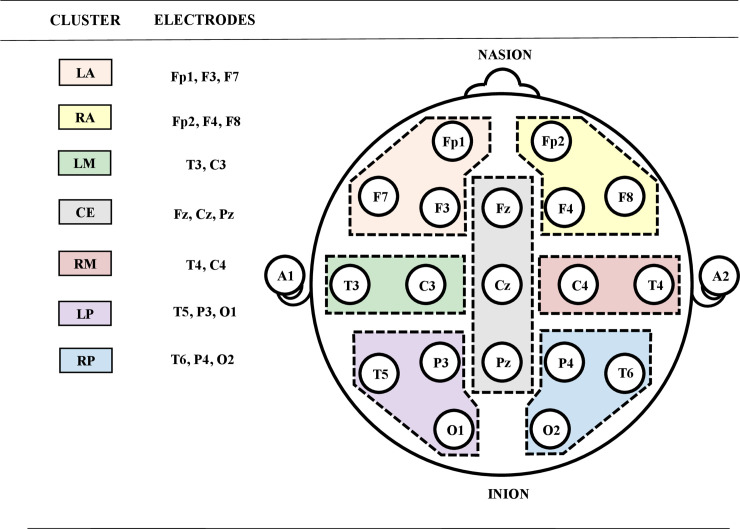
A scheme of electrode montage.Clusters were presented from anterior (left, cluster LA orange and right, cluster RA yellow), left middle (cluster LM green), central (cluster CE gray), right middle (cluster RM red) and posterior (left, cluster LP purple and right, cluster RP blue).